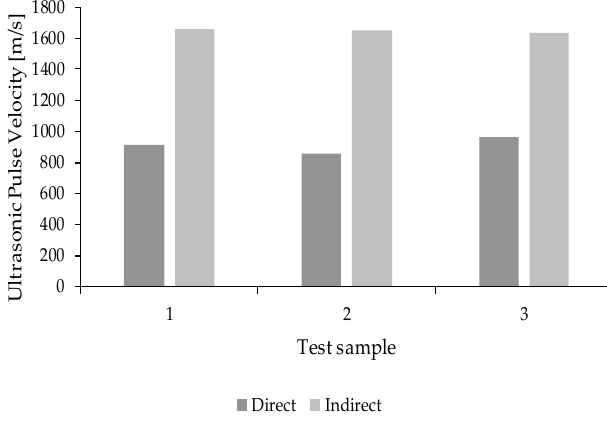
Figure 9. Ultrasonic Pulse Velocity measurements.